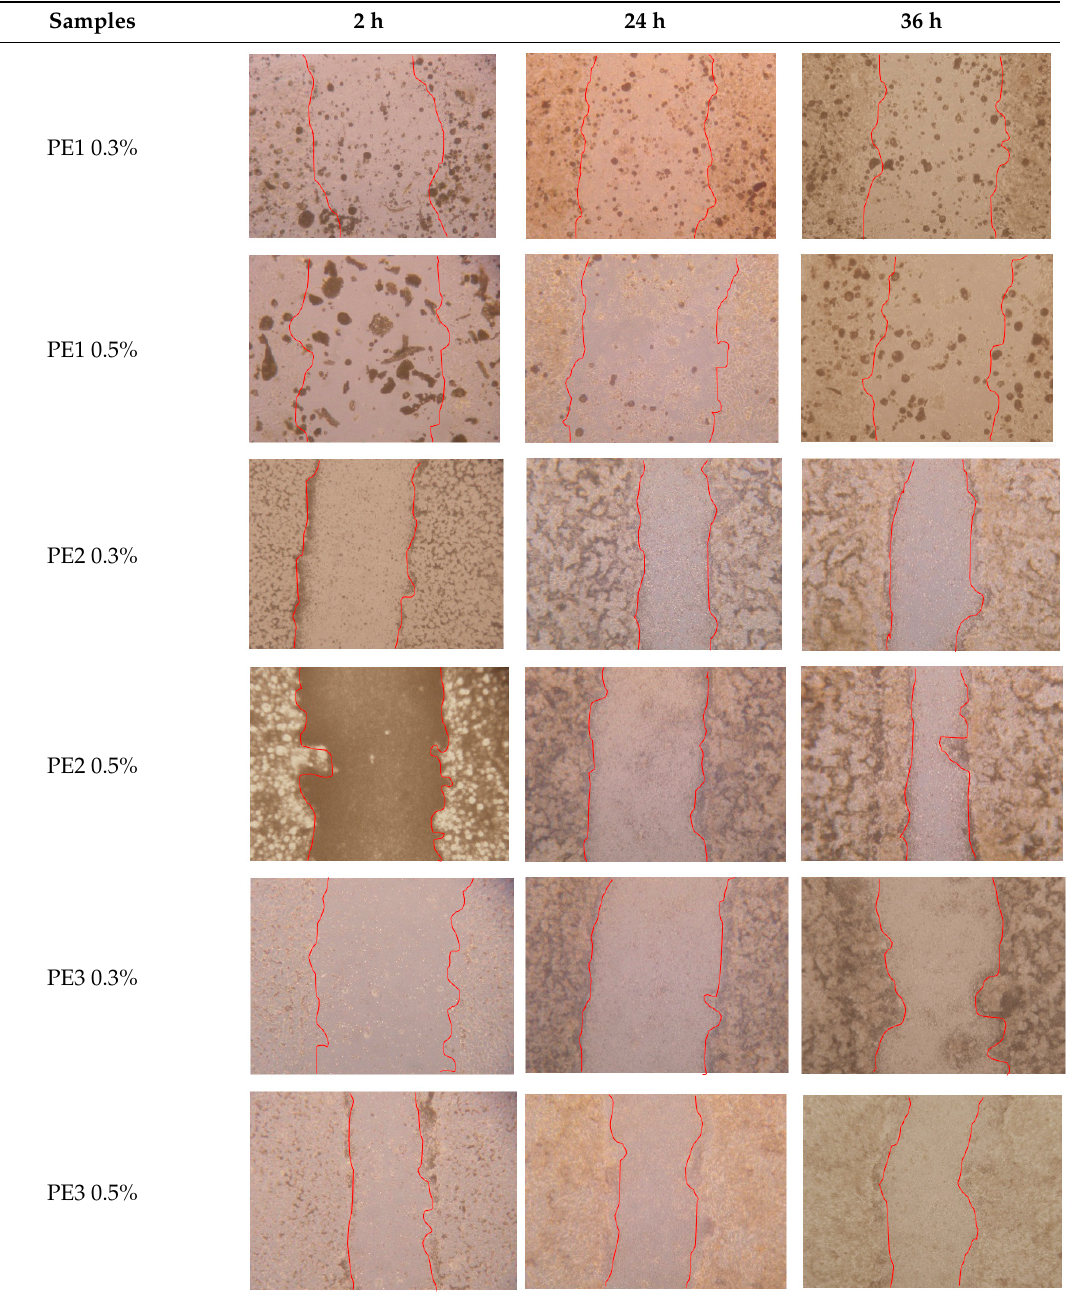
Table 4. Microscopic images obtained from the scratch wound-healing assay with the propolis extracts (magnification: 100×)